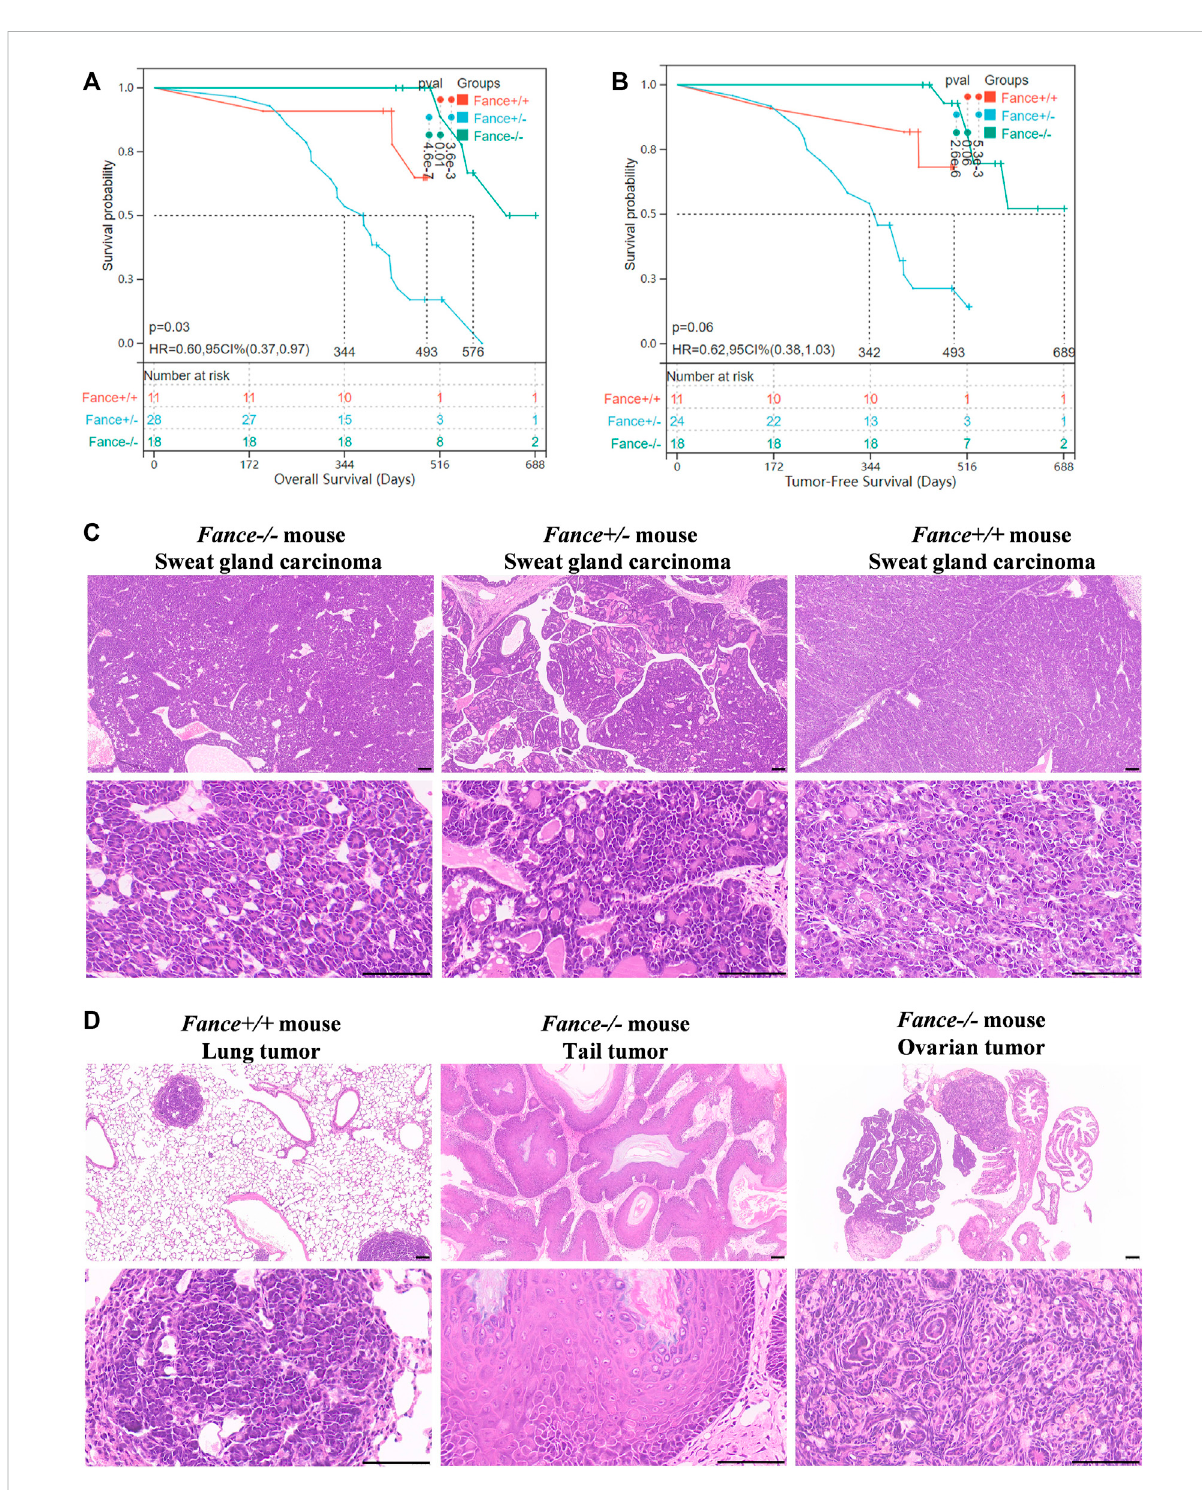
FIGURE 13 Survival curves and histology of carcinomas in Fance homozygous mice, Fance heterozygote mice, and wild-type mice with FVB/N background. Overall survival curves (A) and tumor-free survival curves (B) of the Fance − / − , Fance +/- , and Fance +/+ mice cohort. p values were determined by the Log-rank test. p < .05 was considered signi fi cantly different. (C) H&E-stained paraf fi n-embedded sections of sweat gland carcinoma in Fance − / − , Fance +/- , and Fance +/+ mice cohort. (D) Histology of tumors located at lung in Fance +/+ mice. Histology of tumors located at tail and ovary in Fance − / − mice. All scale label = 100